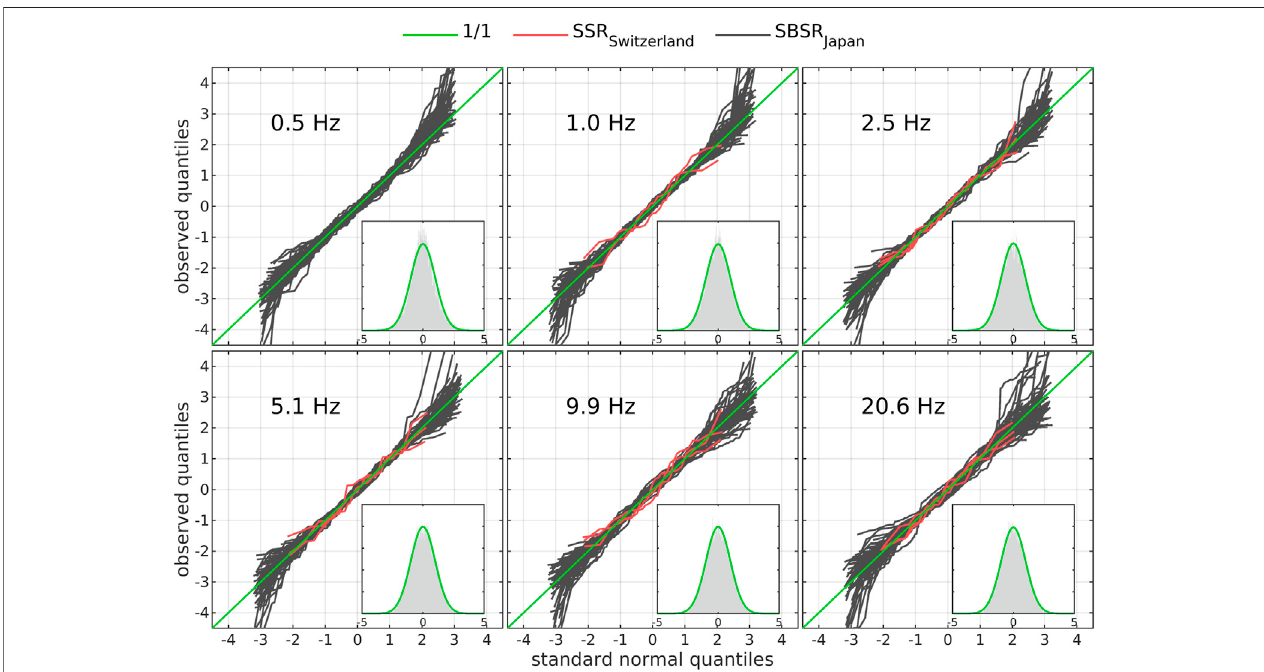
FIGURE 5 | Quantile – quantile plot of the logarithm of the ampli fi cation factors for 60 surface-to-borehole spectral ratios in Japan (gray curves) and three standard spectral ratios in Switzerland (red curves) at six different frequencies (one panel per frequency). On each panel, the histogram (gray area) of the standard normal distribution computed from the logarithm of the ampli fi cation factors at all sites at the corresponding frequency is compared with the best normal distribution fi t (green curve).